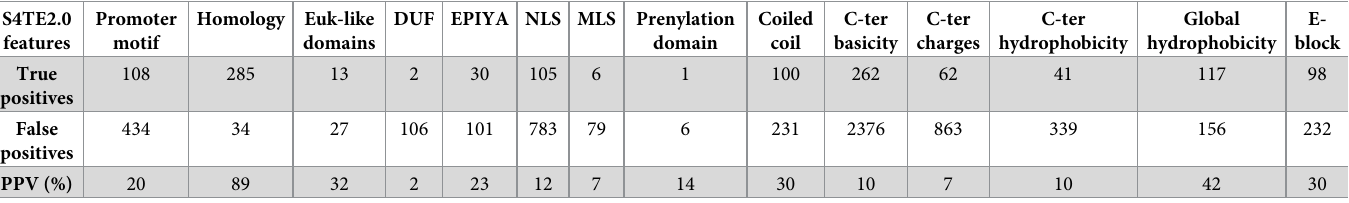
Table 1. Determination of S4TE 2.0 weightings according to the positive predictive value of each S4TE module in Legionella pneumophila Philadelphia 1. Enumera- tion of effectors predicted by individual features implemented in S4TE 2.0: the number of true positives, false positives and the positive predictive value (PPV, expressed in %) is indicated.